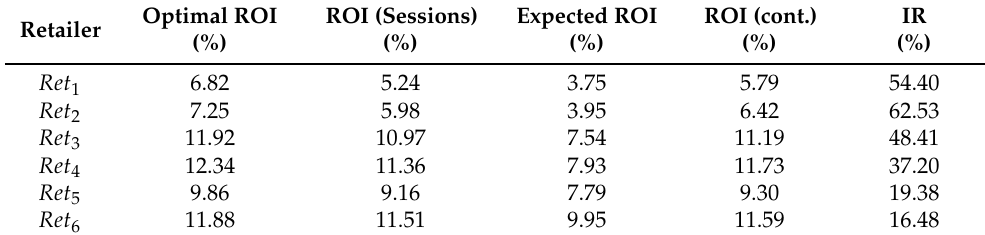
Table 3. Experimental results: market return for